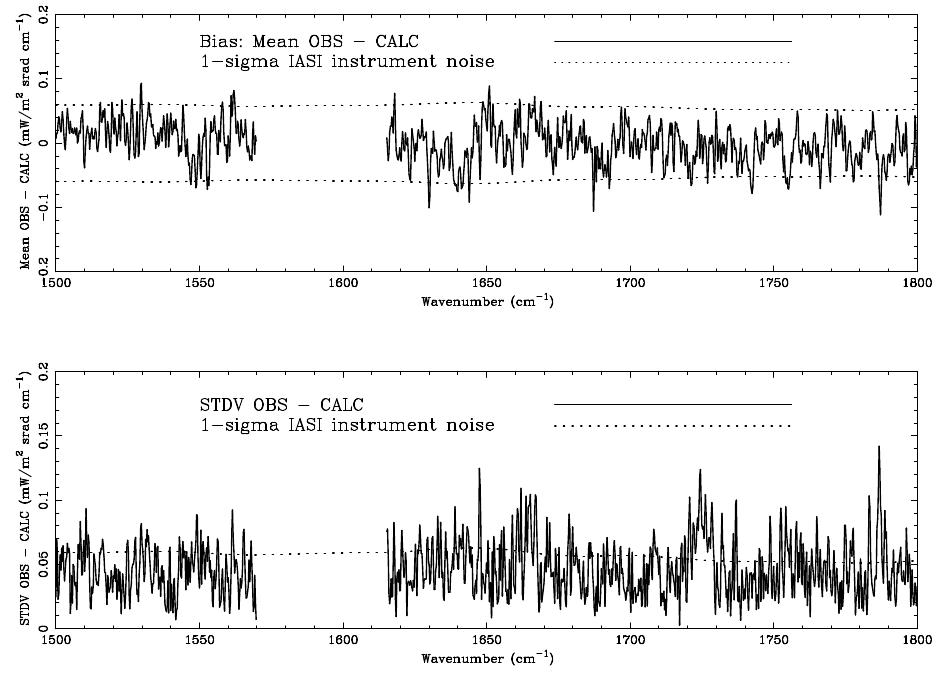
Fig. 15. Bias and standard deviation of IASI observed minus calculated radiances. The calculated radiances have been obtained using LBLRTM 11.6 and the “in situ” bias